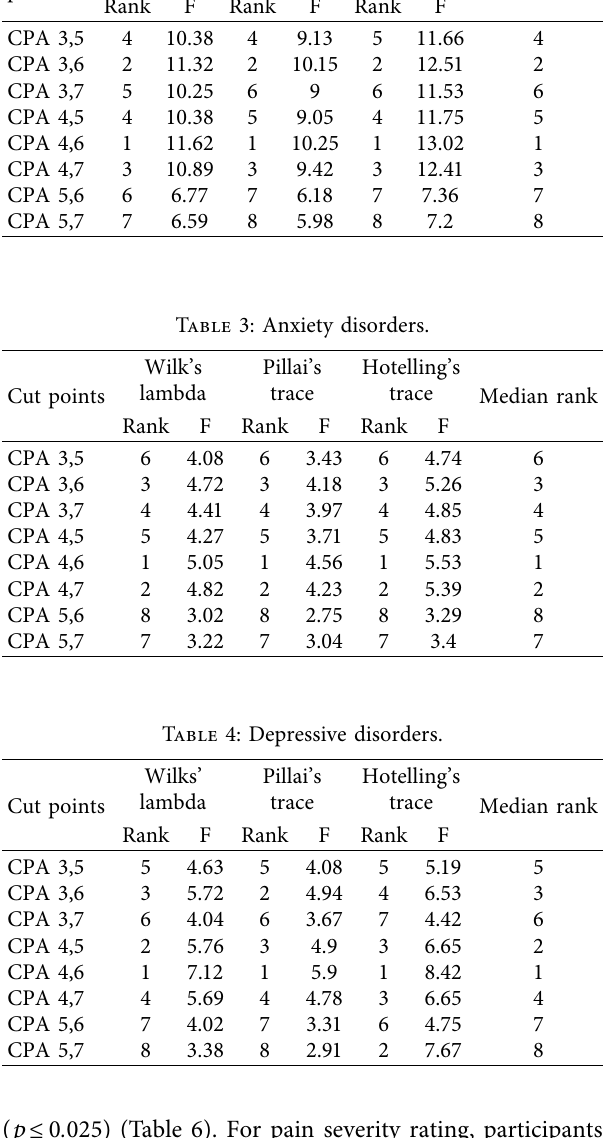
( p ≤ 0 . 025) (Table 6). For pain severity rating, participants with higher BAI scores were seen to be significantly asso- ciated with moderate ( p ≤ 0 . 002) and severe pain ( p ≤ 0 . 001) (versus no pain) (Table 6). High risk for obesity was seen to be significantly associated with severe pain ( p ≤ 0 . 030) (versus no pain) (Table 6).